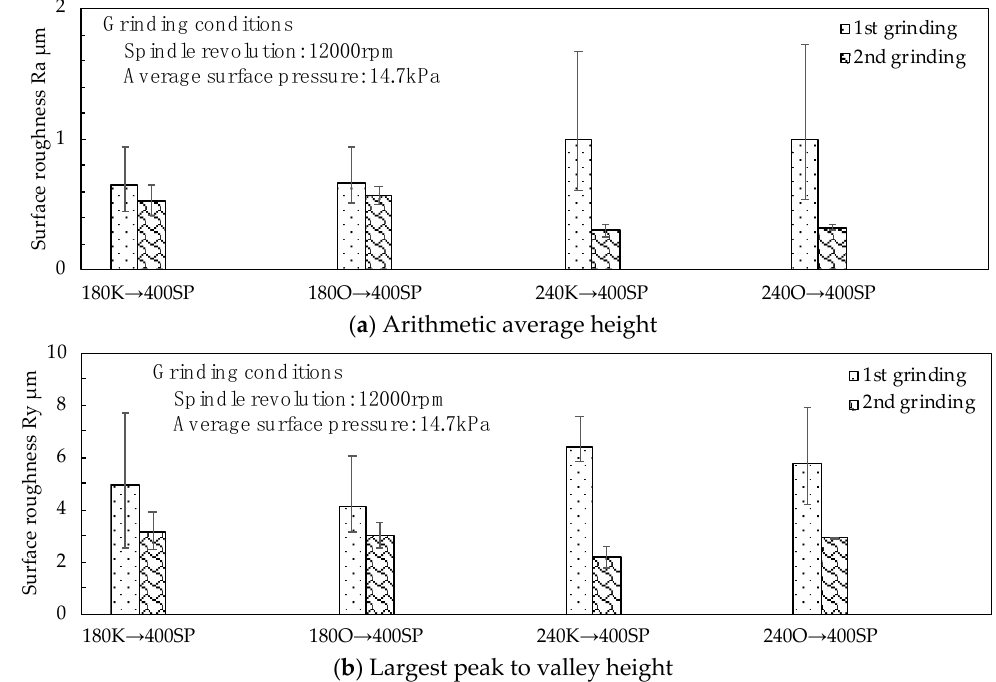
Figure 9. Arithmetic average height and largest peak to valley height of the assessed profile of the steel sheet after grinding.